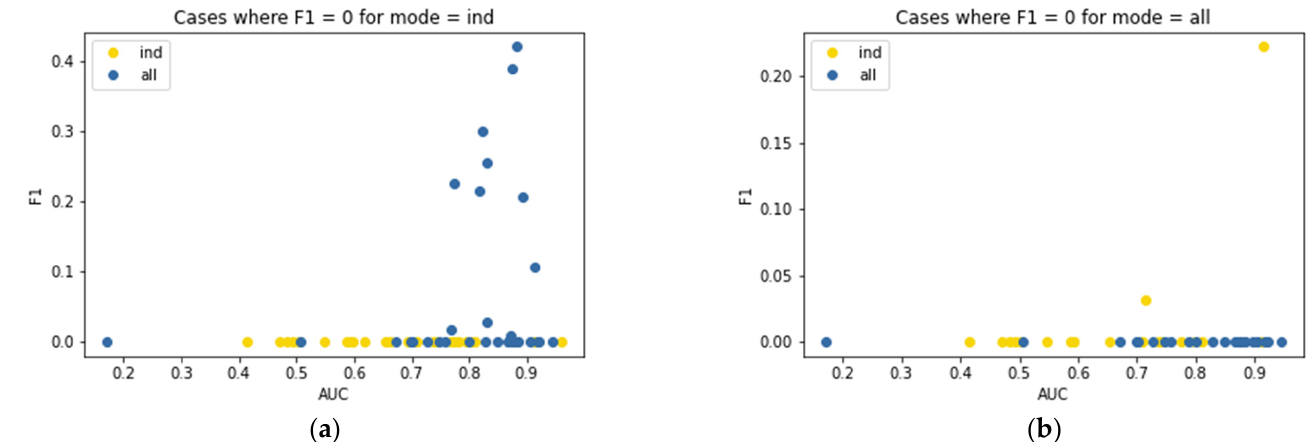
Figure 4. ( a ) F1 score equal to 0 for mode ‘individual’ and corresponding scores of mode ‘all’; ( b ) F1 score equal to 0 for mode ‘all’ and corresponding scores of mode ‘individual’.